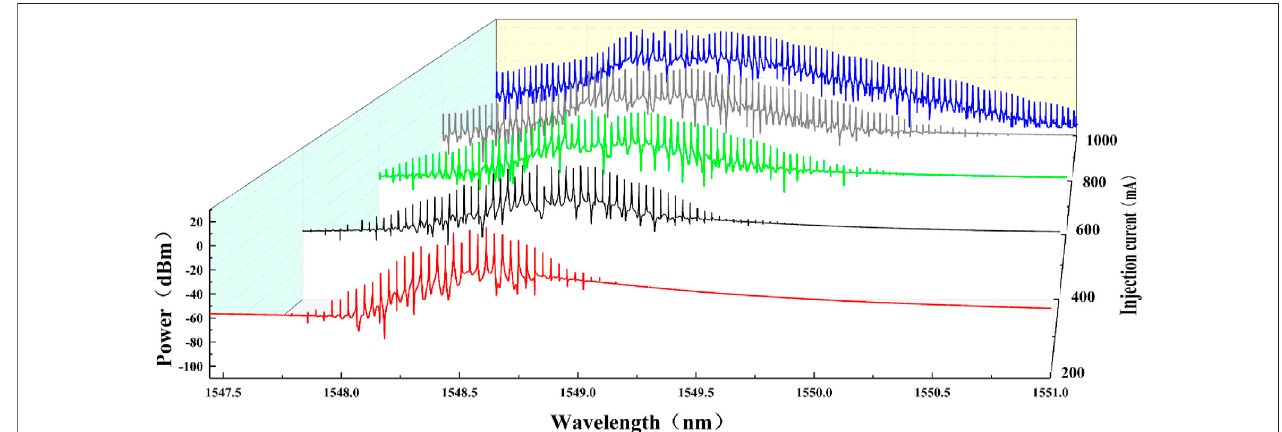
FIGURE 3 | OFCs obtained by simulation under different injection currents of the SOA.